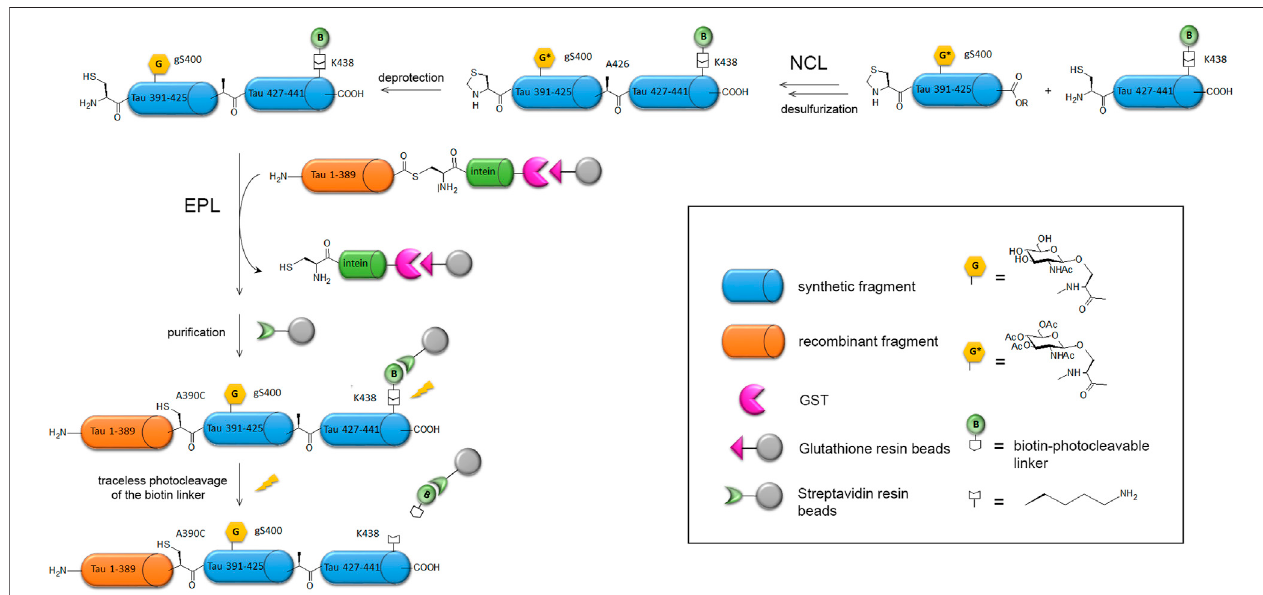
FIGURE 5 | EPL strategy applied to the semisynthesis of full-length tau-S400-O-GlcNAc protein (Schwagerus et al., 2016). The C-terminal synthetic fragment incorporating the S400-O-GlcNAc modi fi cation and a biotin selectively linked to K438 residue for puri fi cation is obtained by NCL of two synthetic peptides, followed by desulfurization to restore the native A426 at the ligation site and deprotection of the GlcNAc moiety. The resulting C-terminal S400-O-GlcNAc peptide is then ligated by EPL with the N-terminal fragment recombinantly expressed as intein-GST fusion puri fi ed on glutathione af fi nity chromatography. The ligation product is isolated from the unreacted recombinant fragment through streptavidin-biotin af fi nity chromatography and traceless released by photocleavage of the biotin linker. The fi nal product is the full-length protein tau-S400-O-GlcNAc with a A390C mutation at the EPL ligation site that cannot be recovered by desulfurization due to the presence of two native cysteine in tau